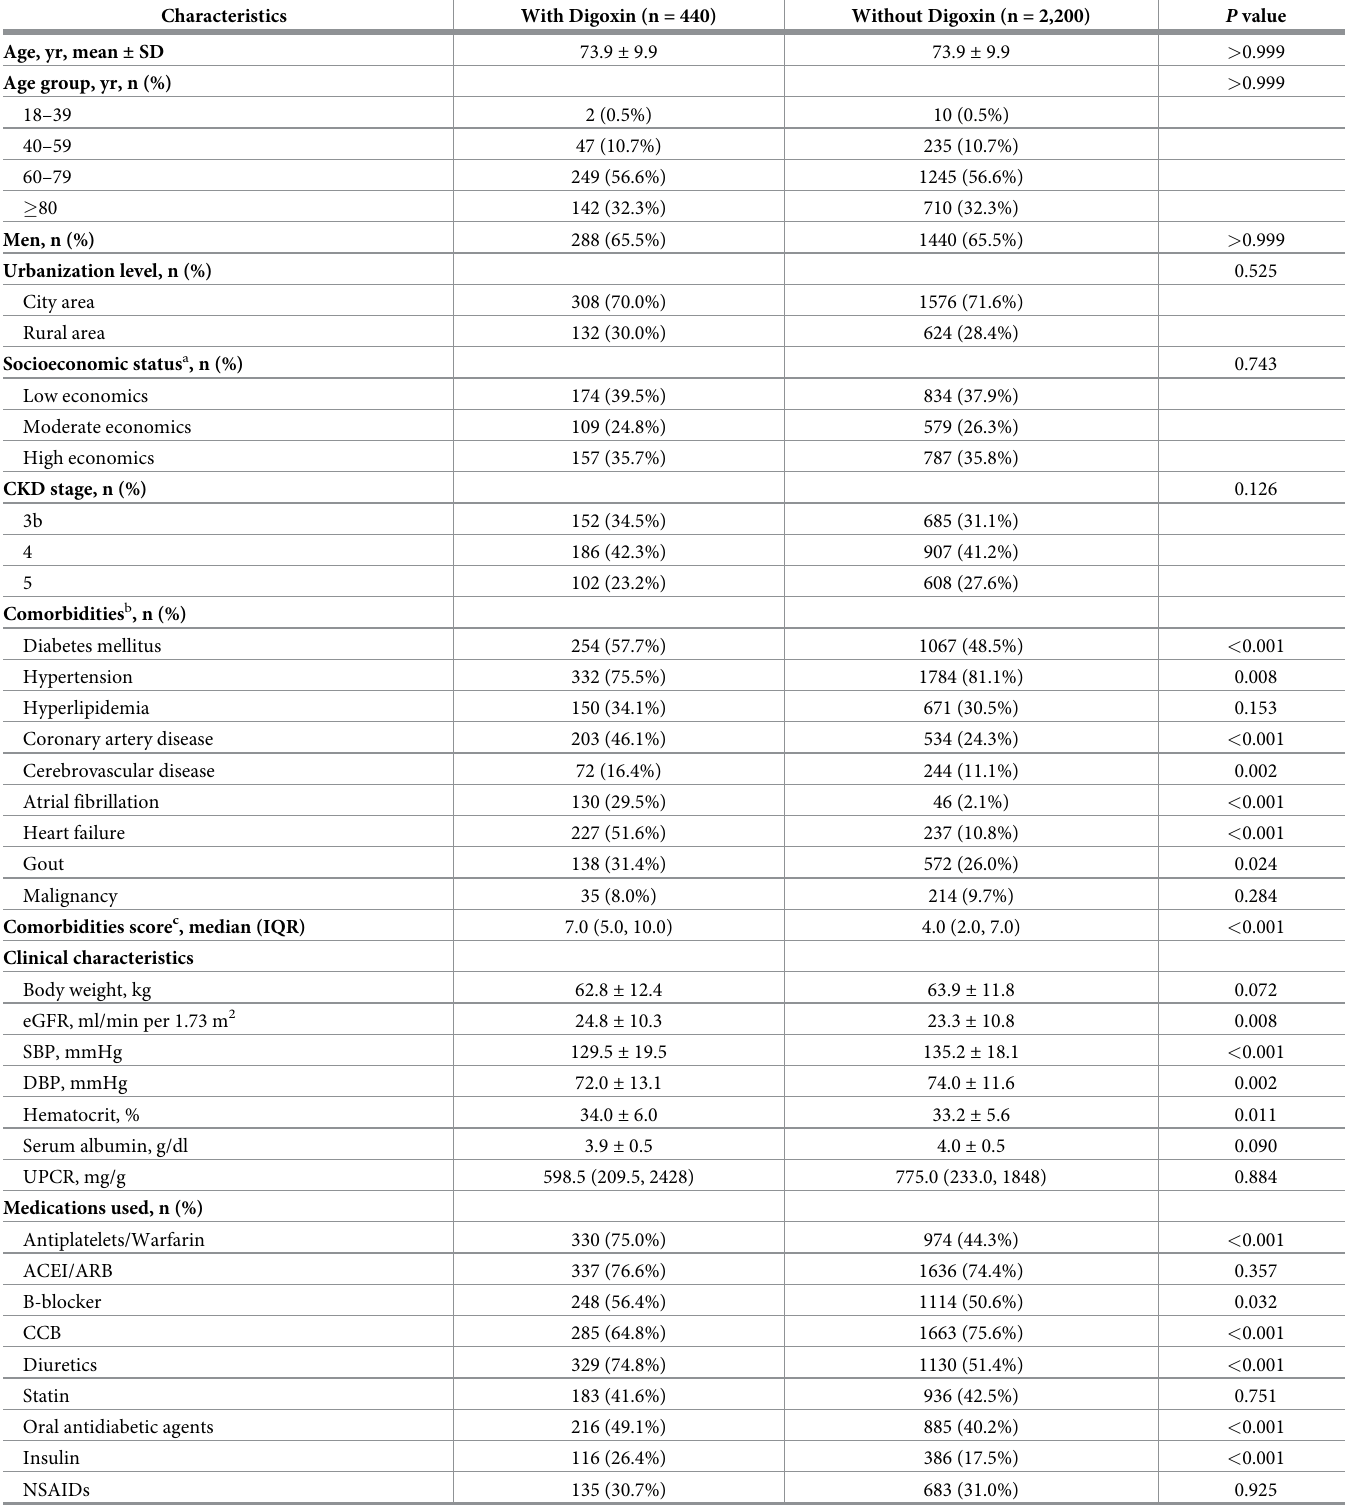
Table 1. Baseline characteristics among patients with chronic kidney disease receiving digoxin or